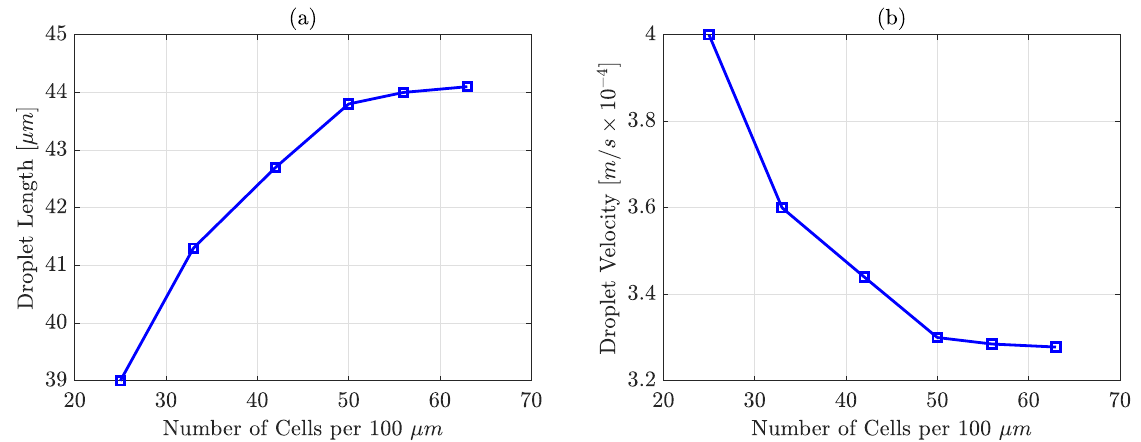
Figure 4. Effect of number of grids on ( a ) droplet length, ( b ) droplet velocity. The properties of continuous phase, oil, are µ c = 2.23 × 10 − 2 Pa · s, ρ c = 0.93 × 10 3 kg/m 3 U c = 0.064m/s, and for dispersed phase, aqueous polymeric solution, viscosity calculated by power-law ( K = 0.3125Pa · s n , n = 0.389 ) ; ρ d = 0.997 × 10 3 kg/m 3 , U d = 0.0016m/s; σ = 0.072N/m; θ = 160 ◦